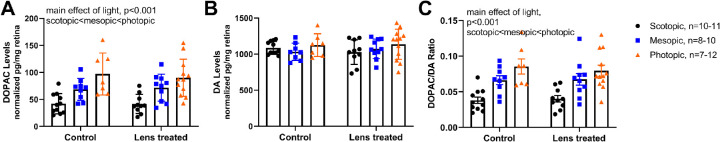
DA turnover increases with illuminance level. Retinas were collected four to six hours after light onset under each housing illumination level. (A) After ∼2 weeks of ambient light exposure, DOPAC levels were increased with higher light intensities in both treatment groups (two-way ANOVA, main effect of light, F(2,53) = 18.47; P < 0.001). For both treatment groups, all light level groups had significantly different DOPAC levels (P < 0.01). (B) None of the treatment groups showed changes in DA levels with light or lens defocus. (C) DOPAC/DA ratio increased with light indicating higher dopamine metabolism at higher light intensities (two-way ANOVA, main effect of light, F(2,53) = 19.45; P < 0.001). For both treatment groups, all light level groups had significantly different DOPAC/DA ratios (P < 0.05). Scotopic samples are represented by black circles, mesopic samples by blue squares, and photopic samples by orange triangles. Bars represent mean ± SEM.